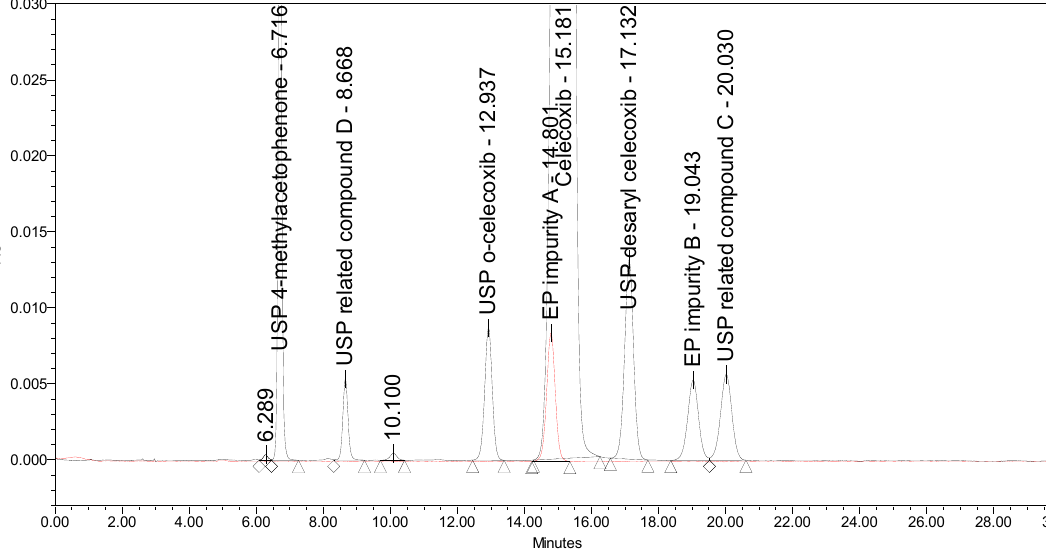
Figure 3. An overlay of chromatograms of celecoxib at a concentration of 1.0 mg/mL spiked with seven investigated impurities at the 0.5% level (black) and of EP impurity A at the 0.5% level (red) obtained using the proposed USP method.